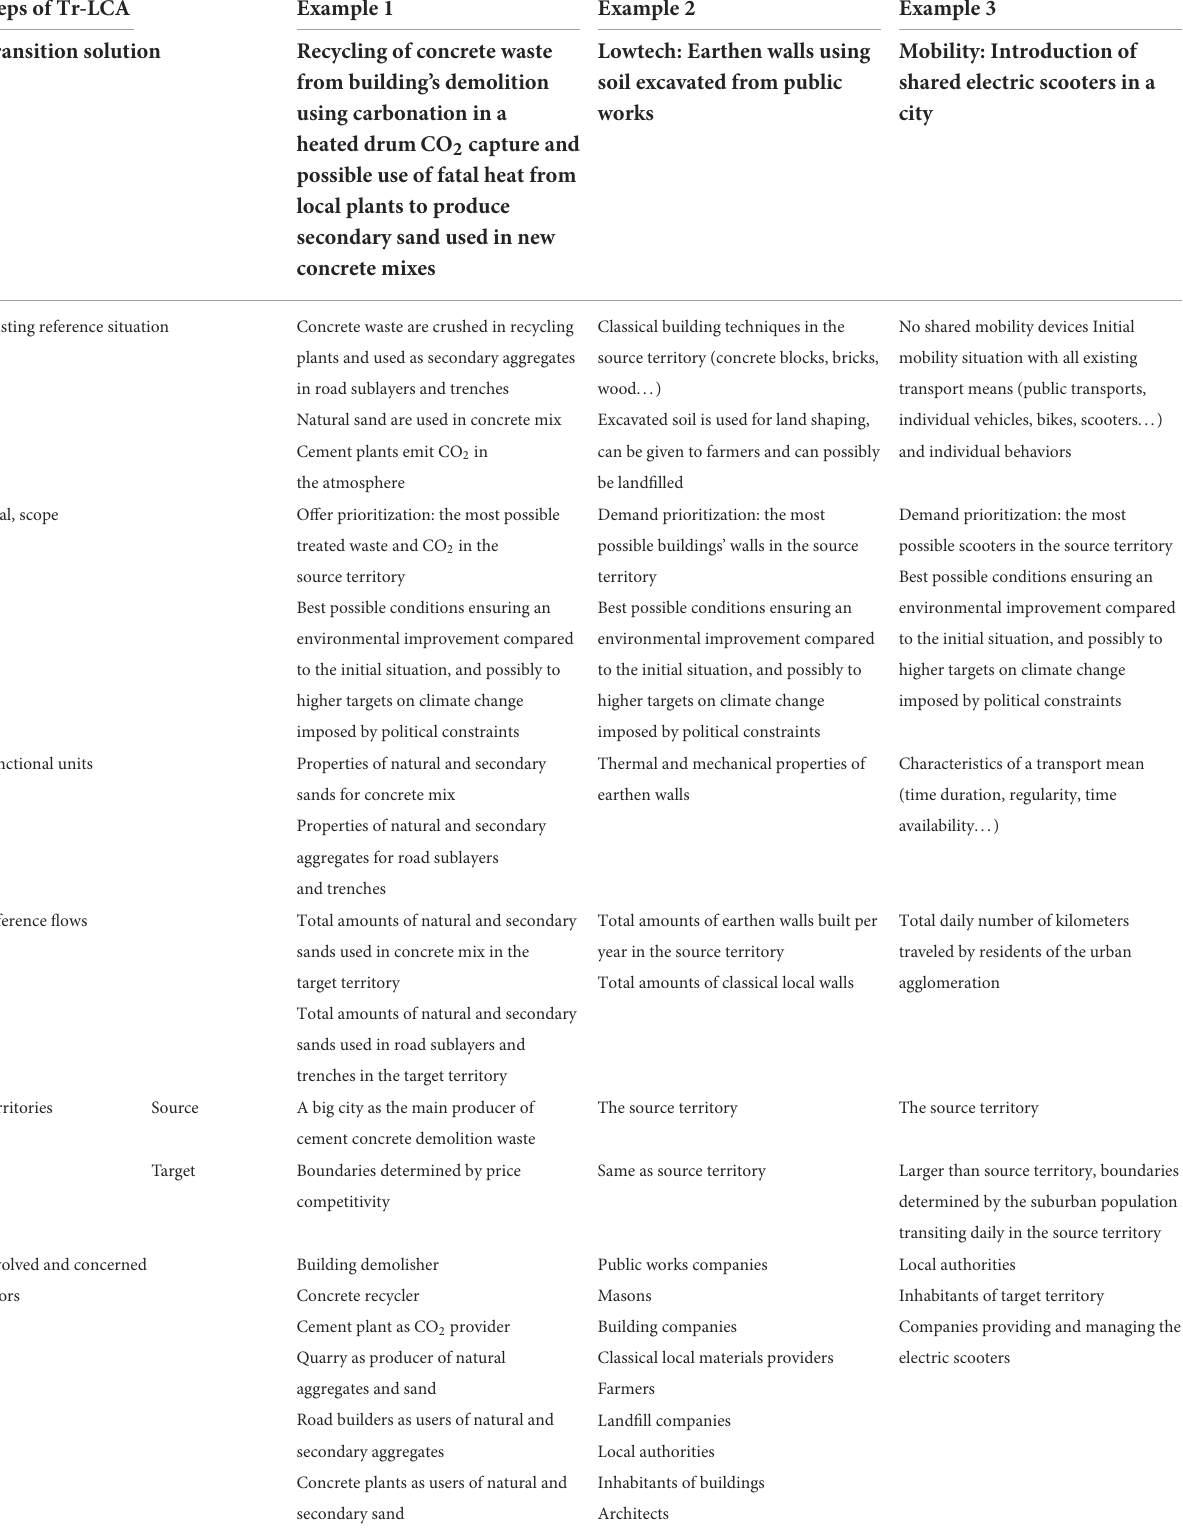
TABLE 5 Examples of different possible case